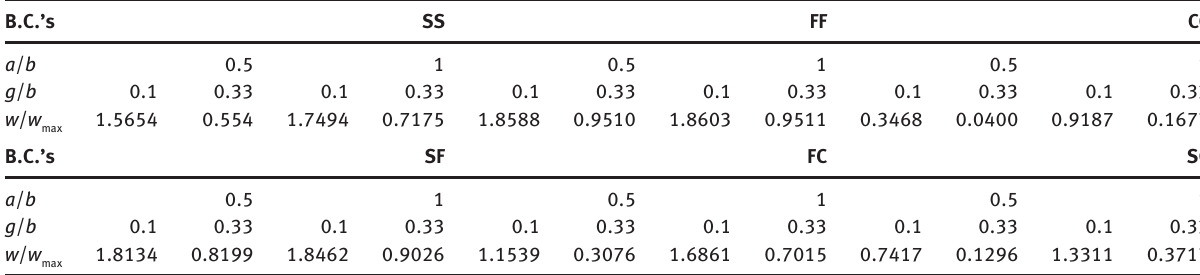
Table 2: Non-dimensional deflection for a functionally graded micro-plate ( n = 1).